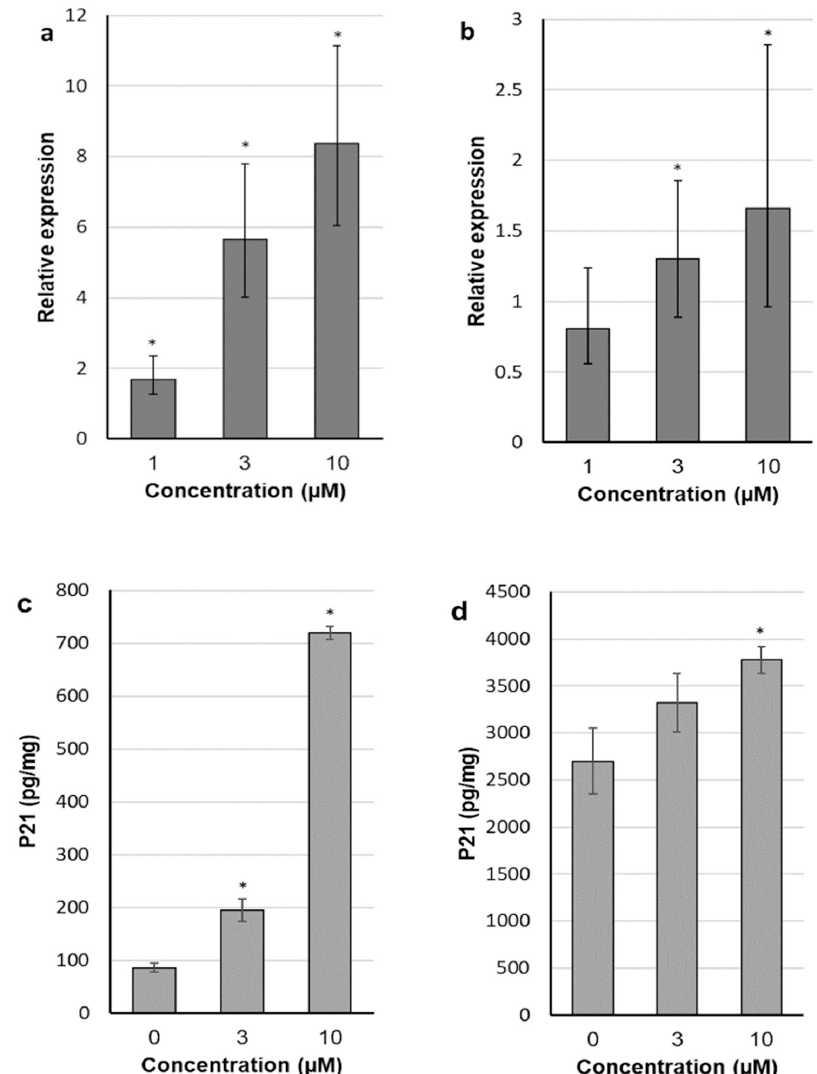
Figure 5. Effect of 6 h exposure to betulin and its derivatives on p21 mRNA ( a , b ) and protein ( c , d ) expression in SK-BR-3 ( a , c ) and MCF-7 ( b , d ) cell lines; each bar represents the mean ± SE ( a , b ) or SD ( c , d ); mRNA levels are expressed as fold change over control; * p < 0.05 compared with